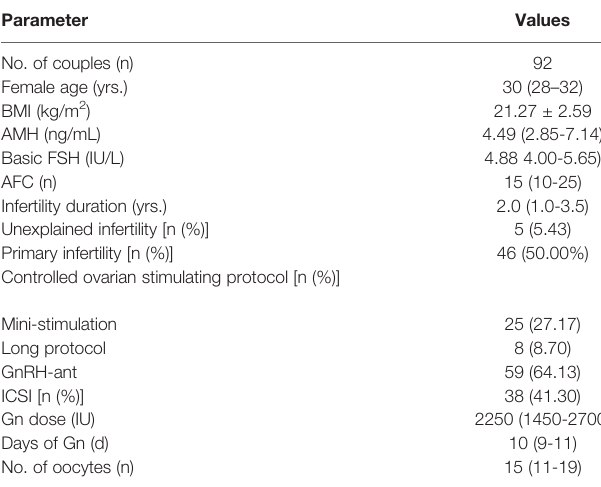
TABLE 1 | Baseline characteristics of included